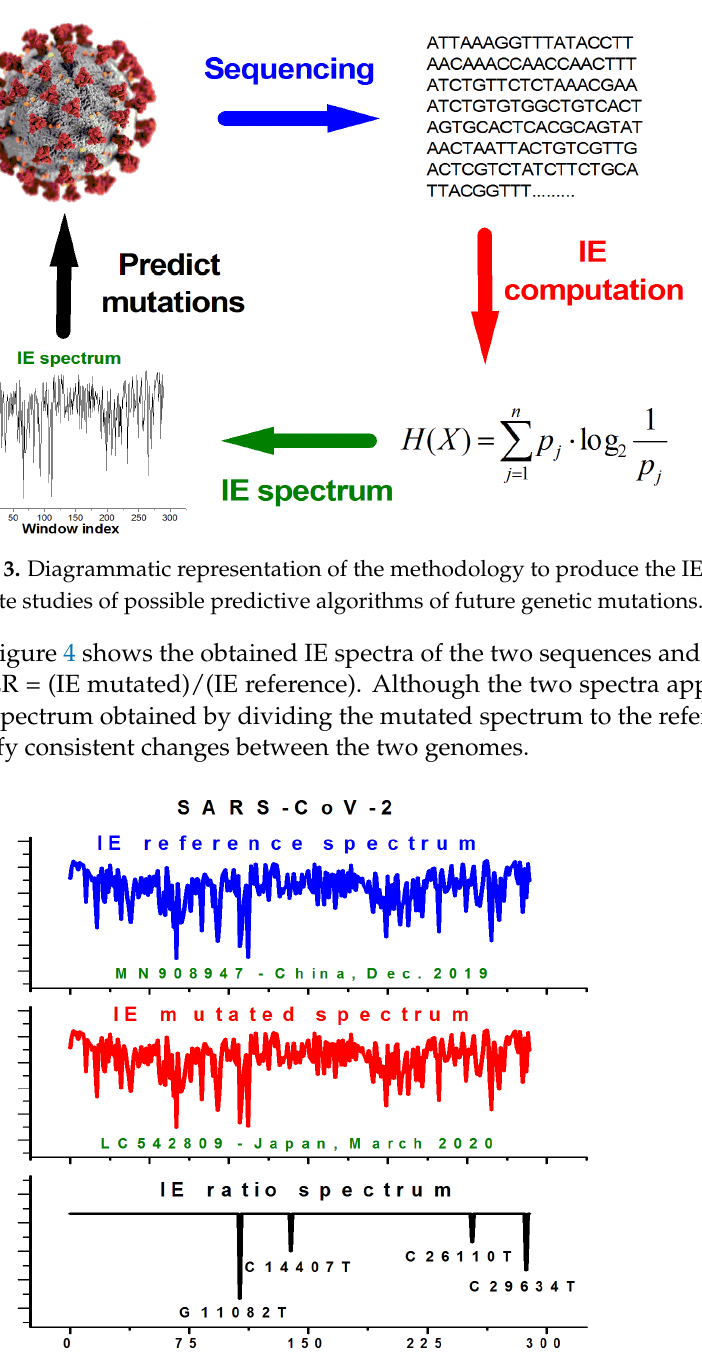
Figure 4. The IE spectra of the reference SARS-CoV-2 genome ( top image), the mutated sequence ( middle image), and their IE ratio (IER) spectrum ( bottom image) obtained by dividing the two IE spectra. The four known mutations are captured in the IER spectrum and clearly marked. The IE of the corresponding window decreased in each case. Data obtained for WS = SS = 103.